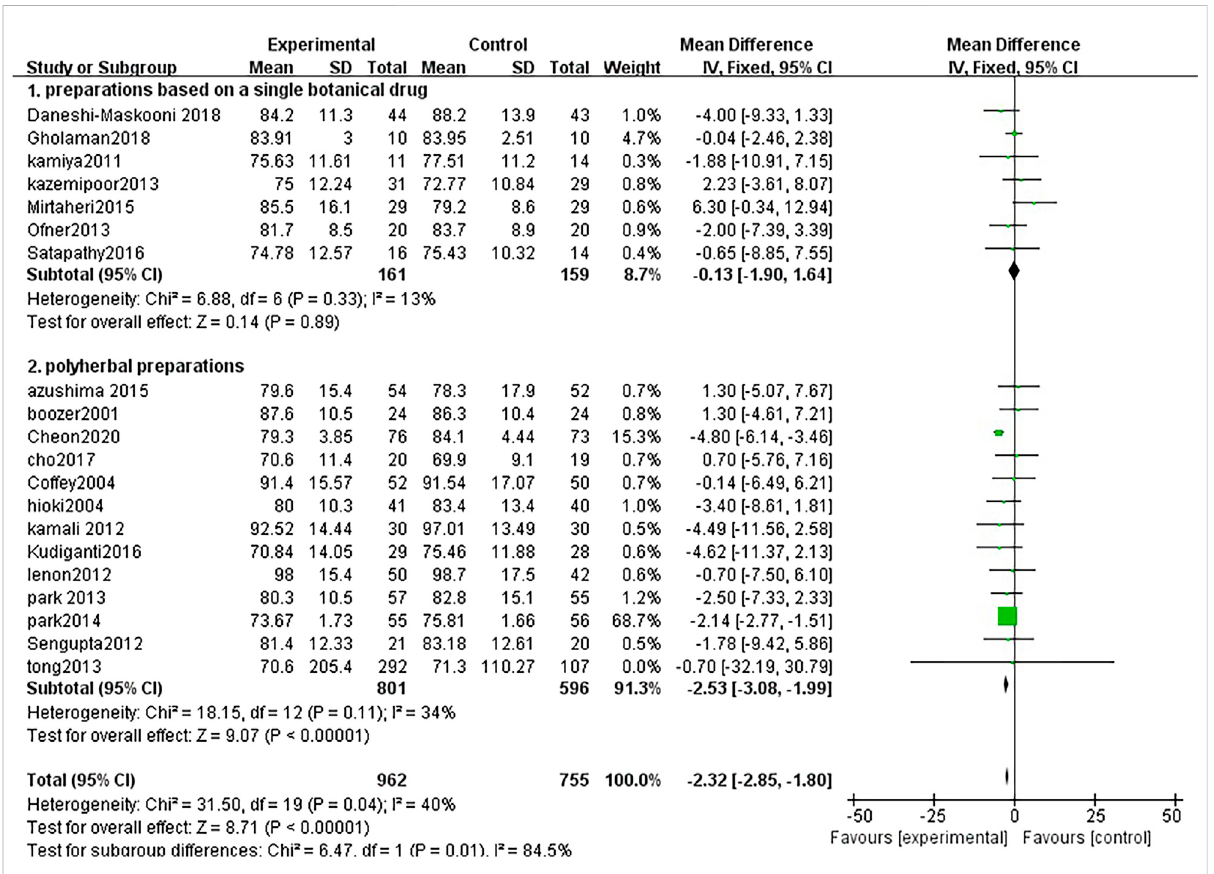
FIGURE 4 Forest plot of weight. Comparison: TCM treatment (1.preparations based on a single botanical drug 2.polyherbal perparations). vs. placeo or blank